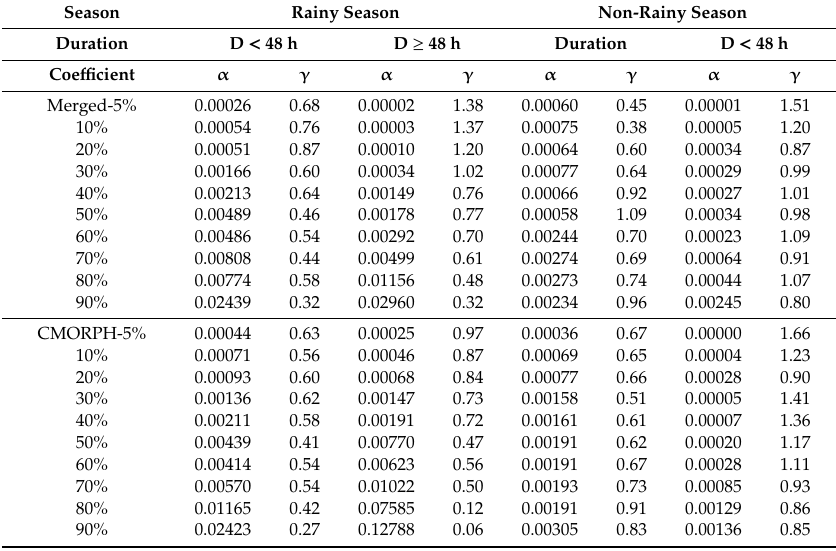
Table 3. Same as Table 2, but for the coe ffi cients of EMAP–D thresholds. (EMAP–D: E–D thresholds normalized by mean annual